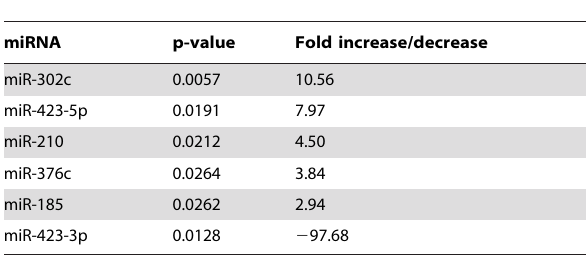
Table 3. List of increased and decreased miRNA in rapidly progressive IPF biopsies (n =9) when compared with slow progressive IPF biopsies (n =6) with p # 0.05.